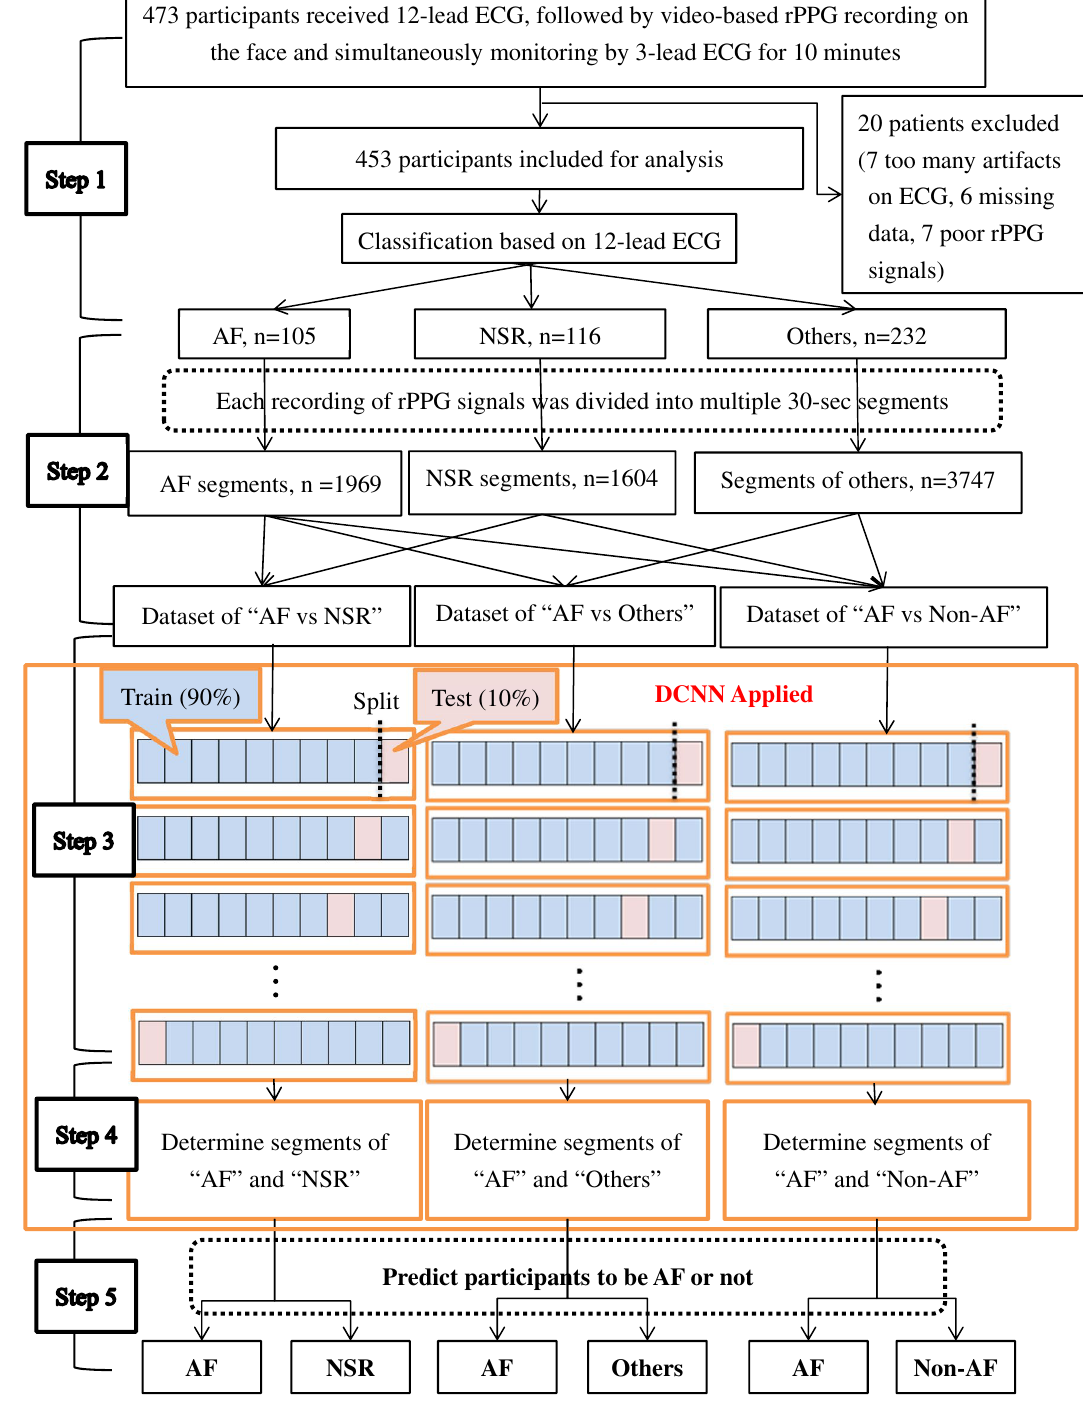
Figure 3. Study flow diagram. AF atrial fibrillation, DCNN deep convolutional neural network, ECG electrocardiograph, NSR normal sinus rhythm, rPPG remote photoplethysmography. Step 1: Case